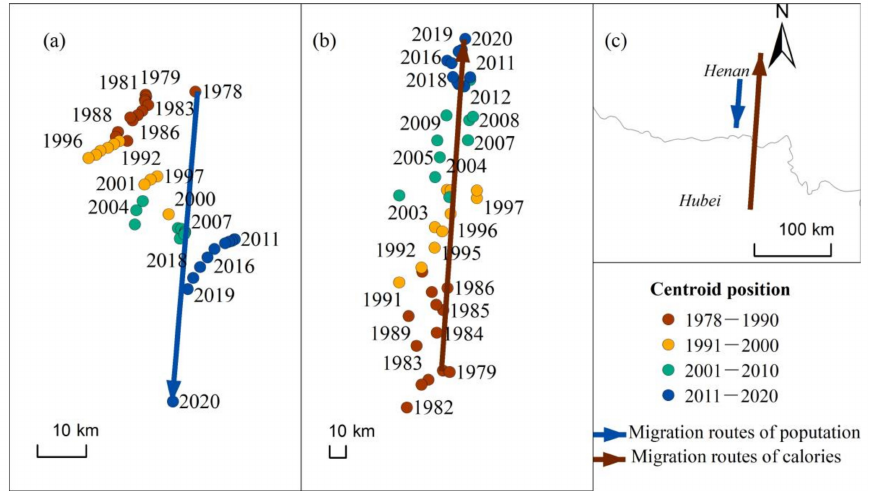
Figure 8. Migration pattern of the centers of gravity of the actual population and food calorie supply from 1978 to 2020: ( a ) population; ( b ) calorie supply; ( c ) trajectory